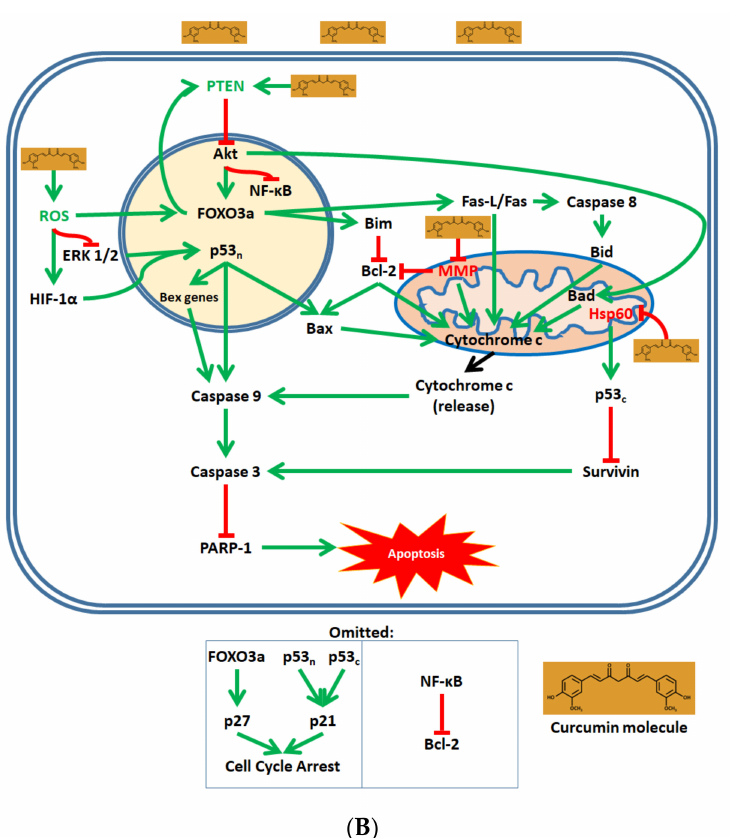
Figure2. Curcumin, asamultitargetcompound, inducesapoptosisandcellcyclearrestinneuroblastoma (NB) cells through the modulation of PTEN–Akt, NF- κ B, and p53 signaling; mitochondrial dysfunction; and caspase activation. ( A ) Intracellular signaling mechanisms within NB cells favor proliferation. The proliferative Akt, NF- κ B, and ERK 1 / 2 pathways, as well as the antiapoptotic Bcl-2 and Survivin proteins, are active and upregulated. Apoptotic signals via mitochondrial dysfunction, cytochrome c release, p53, and caspases are downregulated. Cyclin-dependent kinase inhibitors (p21 and p27) are inactive, allowing for cell cycle progression. ( B ) Curcumin modulates intracellular signaling in NB cells in favor of apoptosis and cell cycle arrest. Curcumin upregulates PTEN, which in turn downregulates Akt and NF- κ B and upregulates FOXO3a and Fas pathway signaling. Moreover, curcumin-induced ROS generation elevates intracellular ROS levels and supports both FOXO3a and p53 n signaling. Together, p53 n , Fas pathway, and Akt signaling, along with mitochondrial membrane potential (MMP) depolarization, promote the release of cytochrome c from the mitochondria into the cytosol, where it supports caspase activation. Mitochondrial dysfunction also involves the downregulation of Hsp60, which ultimately leads to the downregulation of Survivin—a protein that ordinarily inhibits caspase activity. Caspase 3 cleaves PARP-1, causing apoptosis, while FOXO3a and p53 activate cyclin-dependent kinase inhibitors, which induce cell cycle